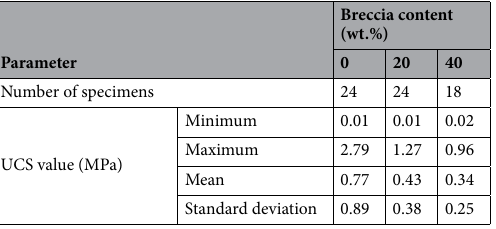
Table 6. UCS values of artificial fault cores for breccia contents of 0, 20, and 40 wt.%.